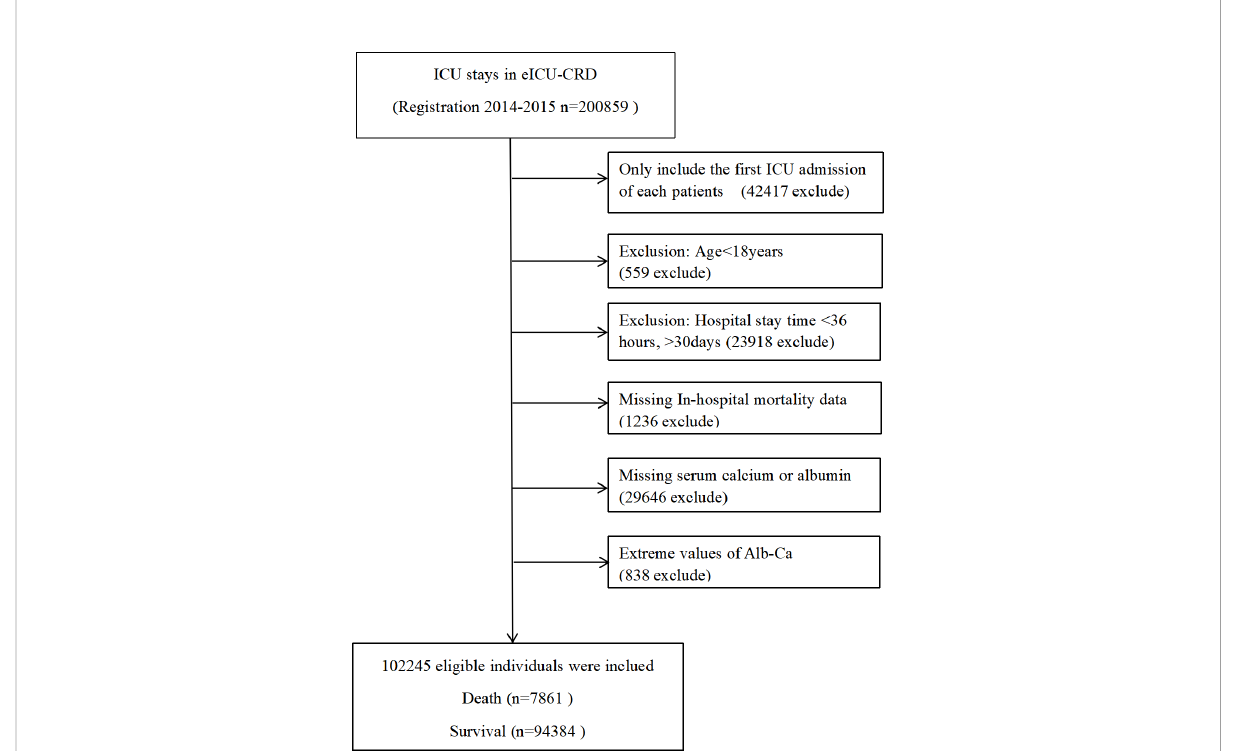
FIGURE 1 The non-linear relationship between albumin-corrected calcium and 30-day in-hospital mortality.The relationship between albumin-corrected calcium and 30-day in-hospital mortality. A non-linear relationship between them was detected after adjusting for age, gender, body mass index, ethnicity, cardiac arrest, gastrointestinal bleeding, diabetes mellitus, cancer, lactic acid, alanine aminotransferase, and serum